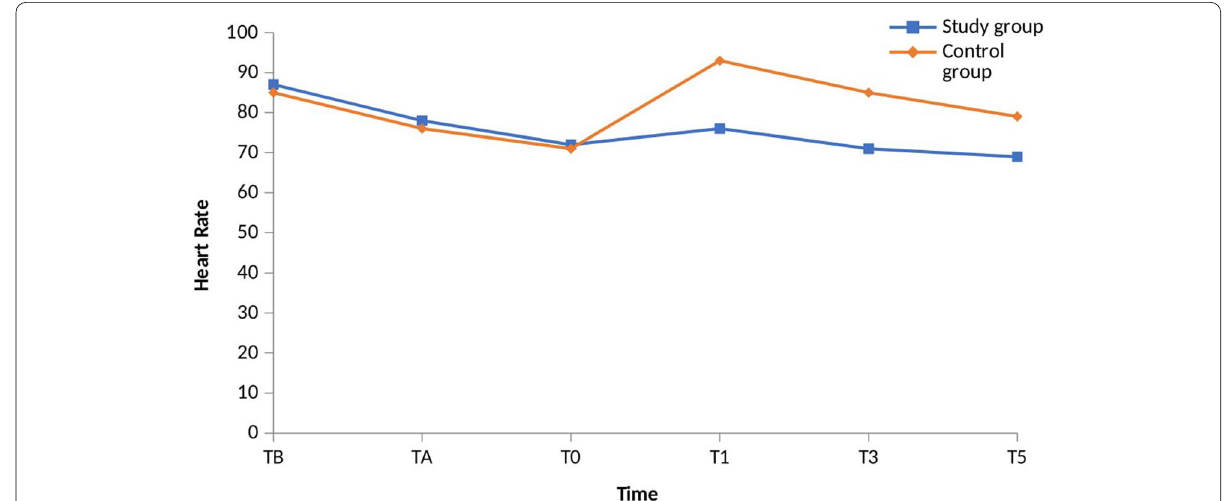
Fig. 2 Changes in heart rate in both studied groups